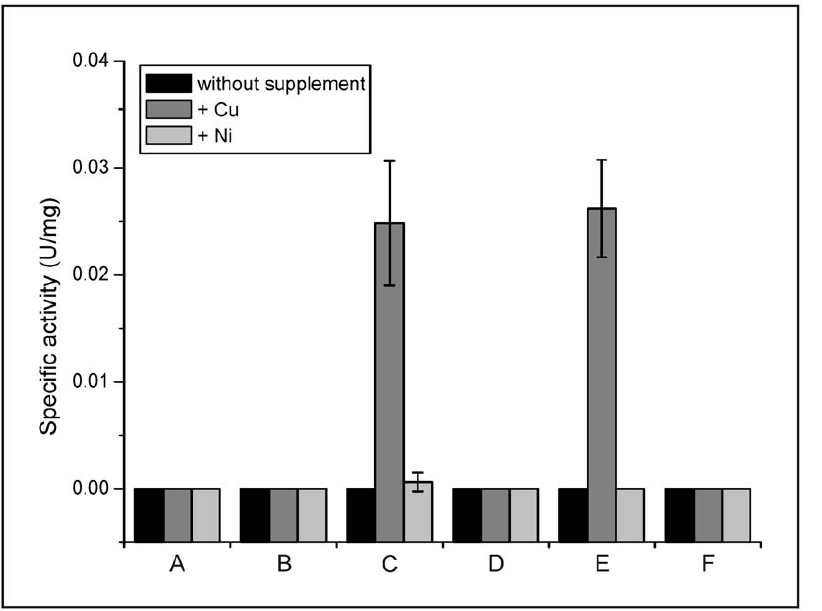
Figure 6. Specific Cat activities of C.glutamicum wild type (wt) and the D copRS mutant. Both strains carrying either the pET2, the pET2-IGR ( copR promoter) or the pET2-IGR_inverse (cg3286 promoter) vector. Cat activities were measured after growth in CGXII medium containing either 1.25 m M CuSO 4 (black bars), 20 m M additional CuSO 4 (dark grey bars) or 20 m M additional NiSO 4 (light grey bars). A, wt/pET2; B, D copRS /pET2; C, wt/ pET2-IGR ( copR promoter); D, D copRS /pET2-IGR; E, wt/pET2-IGR_inverse (cg3286 promoter); F, D copRS /pET2-IGR_inverse. The values represent averages and standard deviations of three biological replicates.